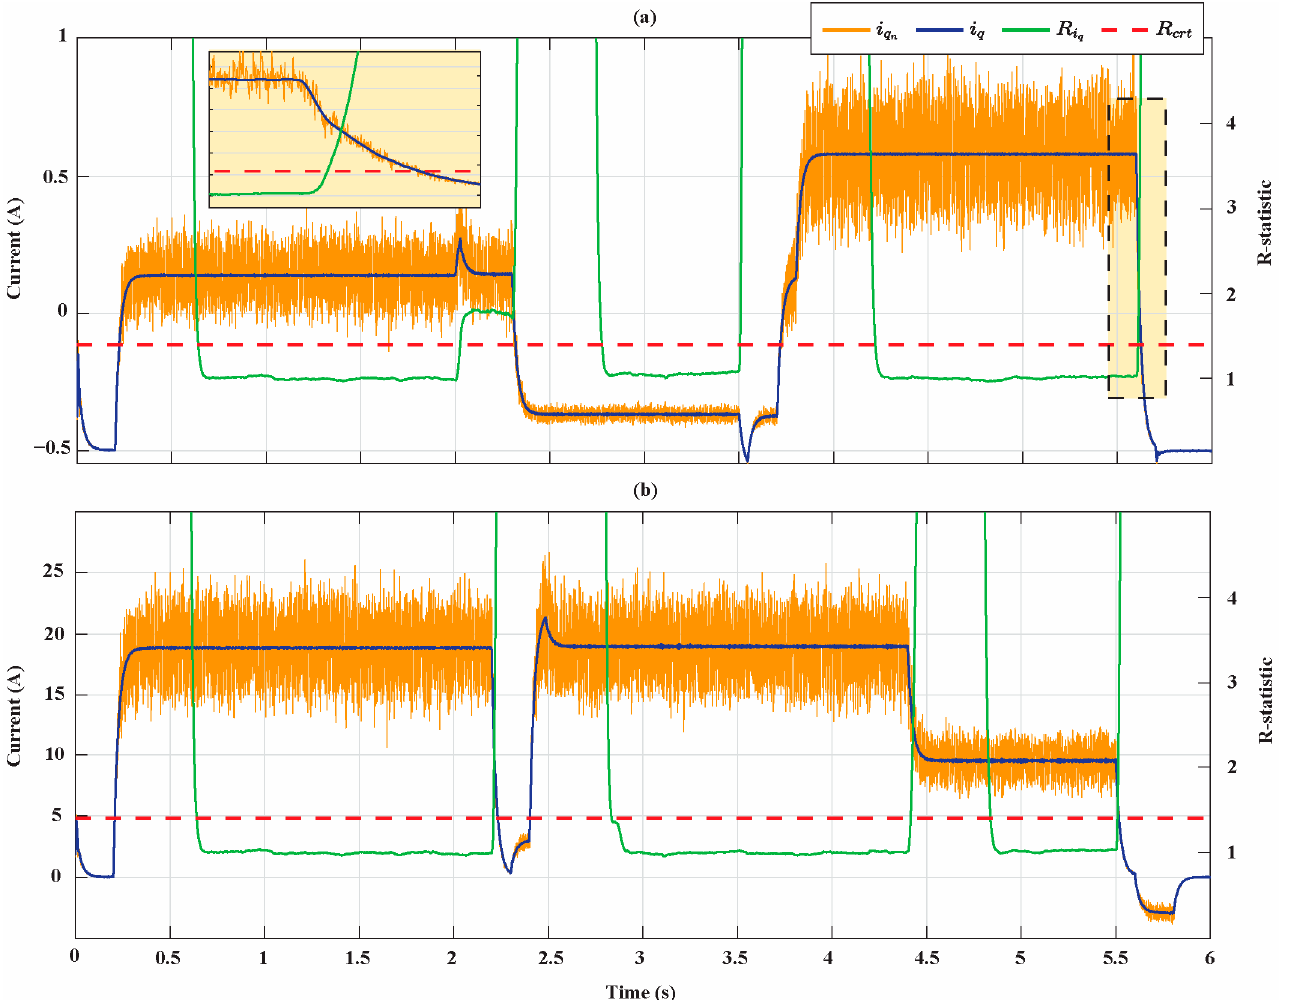
Figure 8. Q-axis current steady-states identification. ( a ) Bonfiglioli 65; ( b ) Bonfiglioli 170.